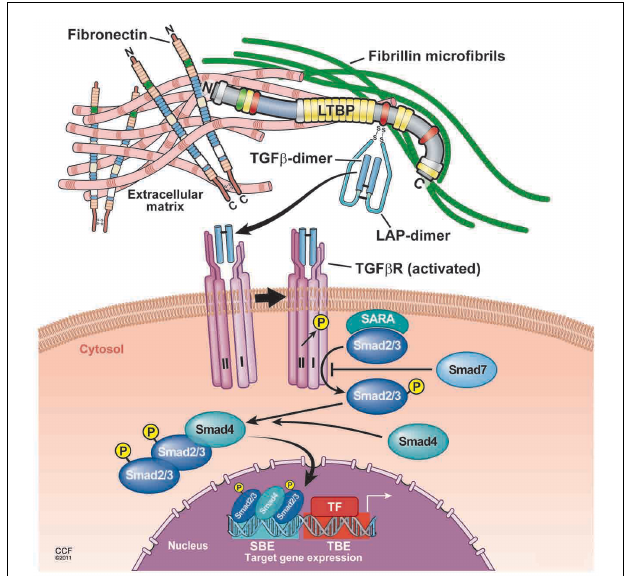
FIGURE 2 | Proposed model ofTGF- β latent complex and activeTGF- β signaling. The LTBP is covalently cross-linked to ECMs such as fibronectin and fibrillin via its N-terminal and C-terminal region, respectively.The small latentTGF- β complex is bound covalently to the third cysteine-rich domain of LTBP. In response to tissue injury, release of activeTGF- β from latent complex and/or conformational change such as exposure of theTGF- β receptor binding site is induced. Binding of activeTGF- β with theTGF- β receptor type II leads to the phosphorylation and recruitment ofTGF- β receptor type I into a heteromeric receptor complexes.The serine/threonine kinase activity of the activated complex phosphorylates Smad2 and Smad3 that both bind to Smad4 and translocate into the nucleus to enhance gene transcription by cooperating with DNA transcription